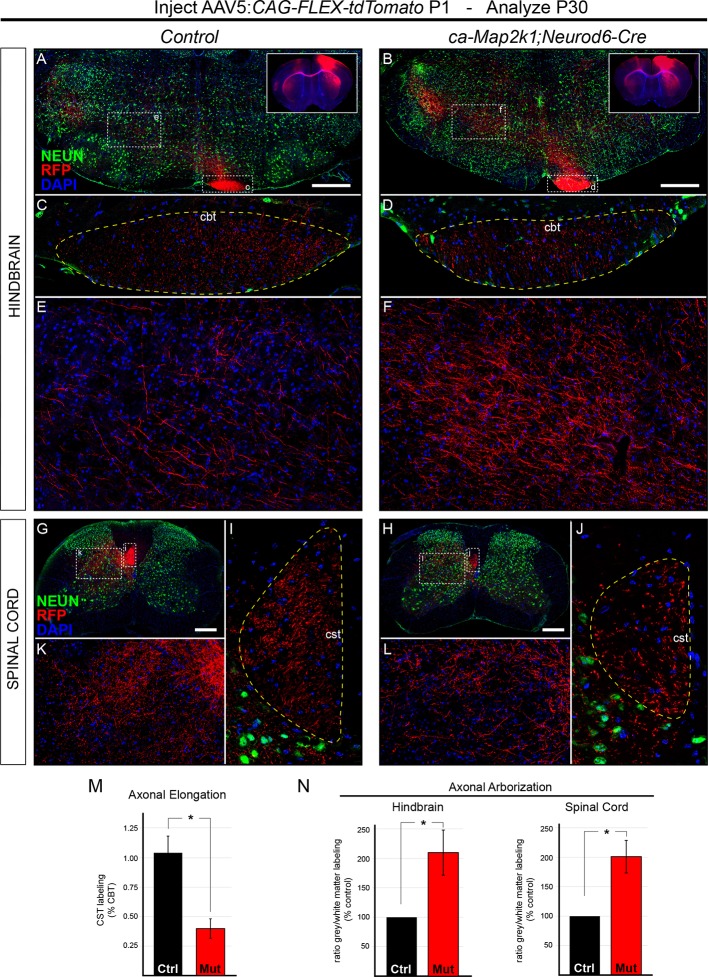
Hyperactivation of ERK/MAPK enhances axonal branching in the hindbrain and spinal cord.(A–J) AAV5-FLEX-tdTomato injections into control (Neurod6-Cre) and ca-Map2k1;Neurod6-Cre motor cortices at P1 (inset in A–B) results in labeling of subcerebral axon projections in P30 hindbrains (A–F) and spinal cords (G–L). To measure axonal elongation from the hindbrain to spinal cord, high resolution confocal images of the extent of axonal labeling in sections of the hindbrain corticobulbar tract (cbt, C–D) and brachial spinal cord corticospinal tract (cst, I–J) were collected and compared. The ratio of corticospinal to corticobulbar tract axonal labeling was significantly decreased in ca-Map2k1;Neurod6-Cre mutants (M), providing further evidence for a reduction in corticospinal axon elongation at P30 (n=3, mean ± SEM, *p<0.01, scale bar=500 µm). The extent of axonal branching was measured by comparing the amount of axonal labeling in the hindbrain (A–B, zoom in E–F) or spinal cord grey matter (G–H, zoom in K–L), to the amount of axonal labeling in the corresponding white matter tract, the CBT (C–D) or CST (I–J), respectively. We observed a significant increase in the relative ratio of grey/white matter labeling in ca-Map2k1;Neurod6-Cre mutant hindbrains (n=4, mean ± SEM, *p<0.05) and spinal cords (n=3, mean ± SEM, *p<0.05) when compared to controls (N).